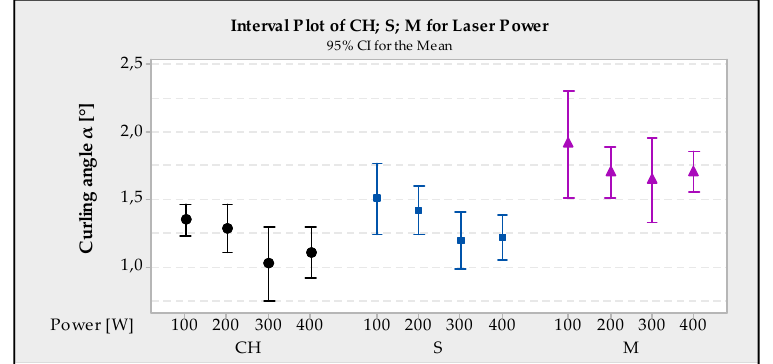
Figure 7. Interval plot of CH, S, M for laser power.